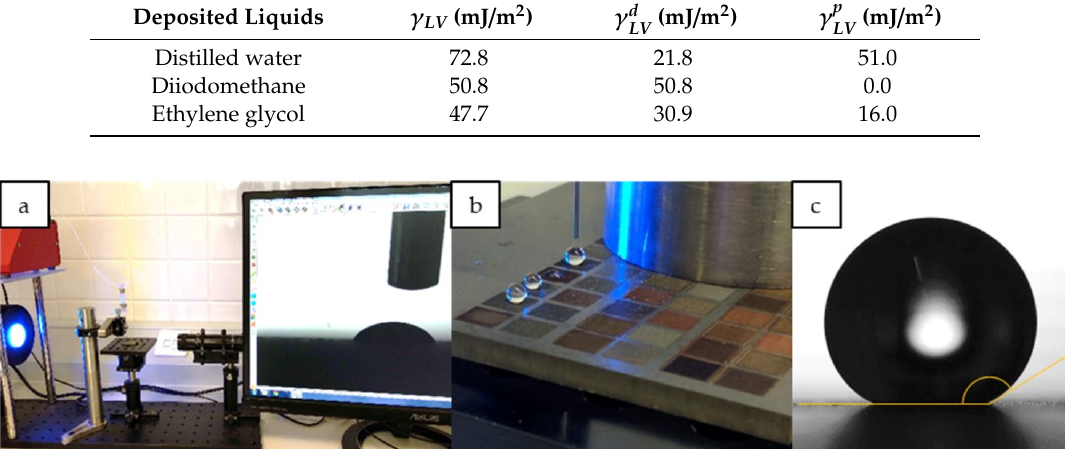
Figure 1. Measurement process and evaluation of contact angle on textured surfaces: ( a ) equipment used for contact angle measurement; ( b ) Drop deposition procedure on textured surfaces; ( c ) Contact angle measurement by image processing software.